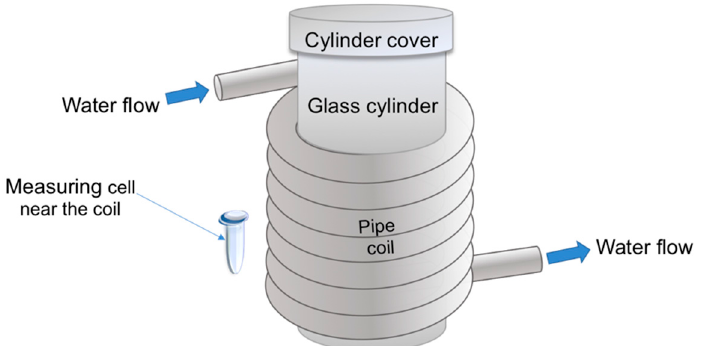
Figure 1. Schematic representation of the experimental setup employed for studying the effect of water flow on the properties of a protein. The measuring cell with the enzyme solution was placed either near the coil or far away. The silicone pipe is spiral-wound onto a glass cylinder to form a coil; water is pumped through the coiled pipe.